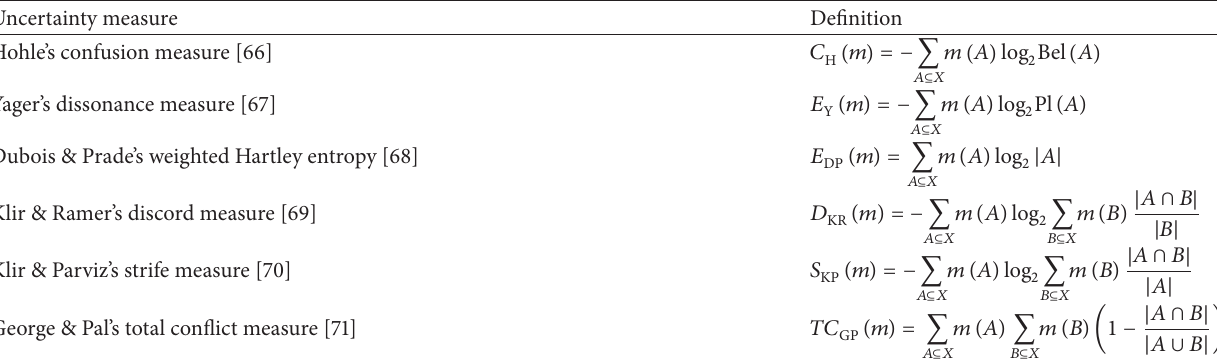
Table 1: Uncertainty measures in Dempster-Shafer